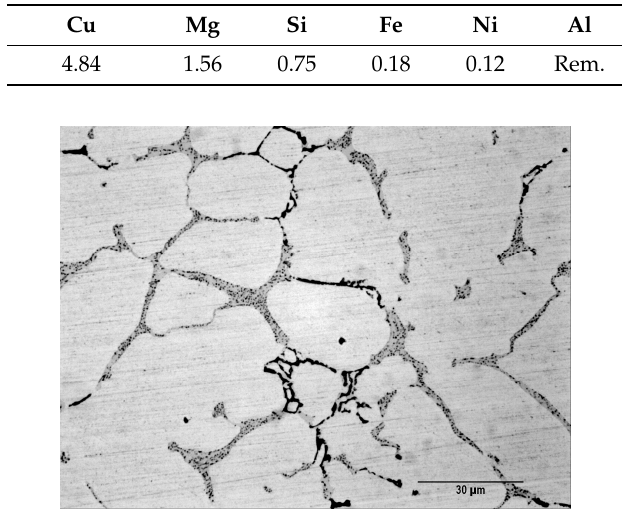
Figure 2. Characteristic microstructure of the material after continuous casting, obtained by optical microscopy. Light gray phase: solid solution (Al); Dark gray phase: Cu 2 Al; Black phase: Mg 2 Si.